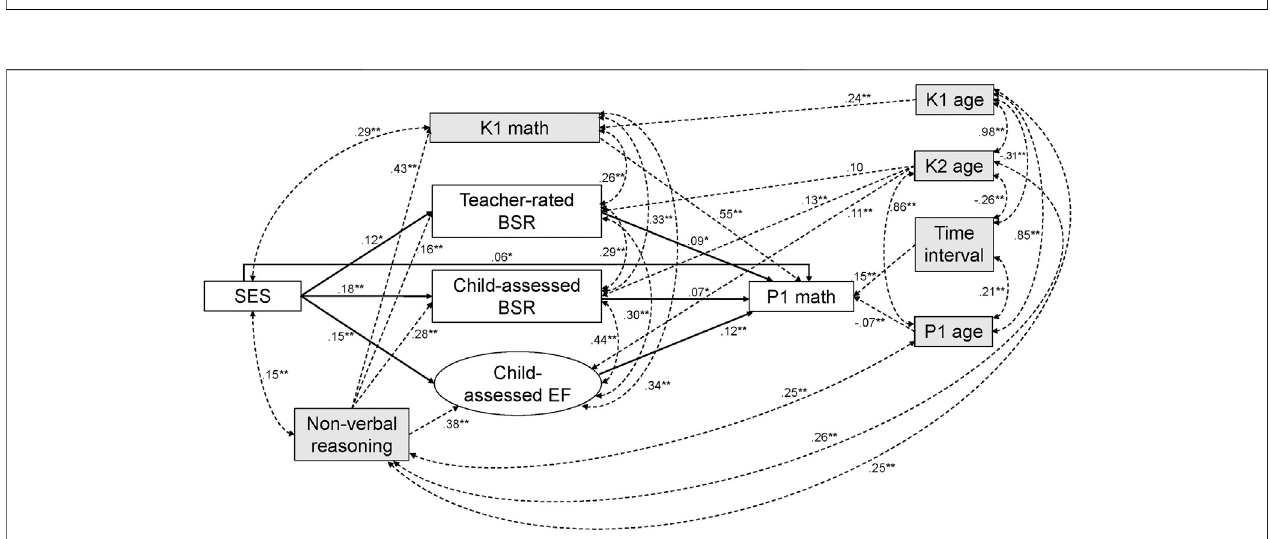
FIGURE 4 | Model 3 examined the roles of child-assessed executive functioning (EF), child-assessed behavioral self-regulation (BSR), and teacher-rated BSR as mediators between socio-economic status (SES) and math achievement at Primary 1 (P1 math), controlling for child ’ s age at Kindergarten 1 (K1), K2, and P1, time interval between K1 and P1 assessment of math skills, math skills at K1, and non-verbal reasoning. Dashed paths re fl ect predictive and correlational paths involving controlvariables.Allpathcoef fi cientsarestandardizedestimates. R 2 EF (cid:1) 0.22, p < 0.01, R 2 Teacher-ratedBSR (cid:1) 0.06, p < 0.05, R 2 Child-assessedBSR (cid:1) 0.16, p < 0.01, R 2 P1math (cid:1) 0.51, p < 0.01, * p < 0.05, ** p <